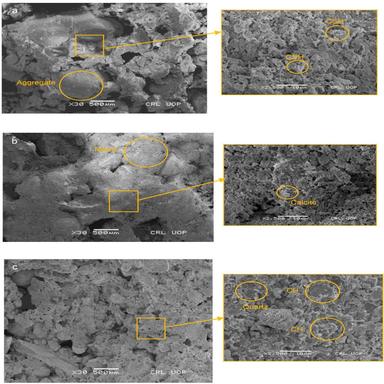
SEM Micrographs of Plaster Samples: a) P1; b) P2; c) P9.